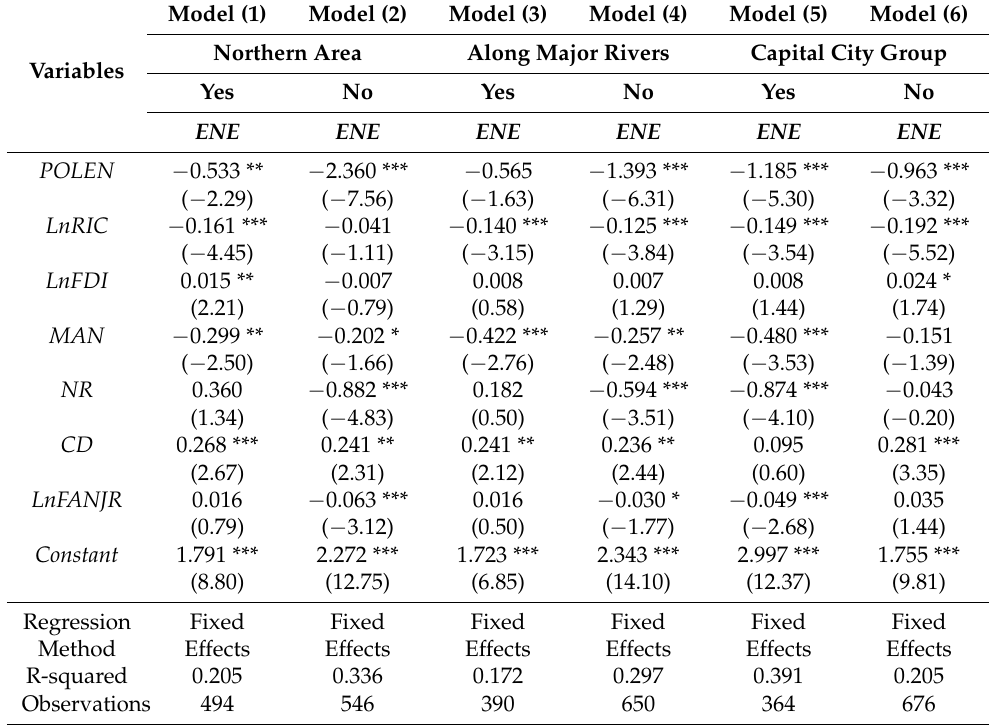
Table 5. Heterogeneity test results A: spatial